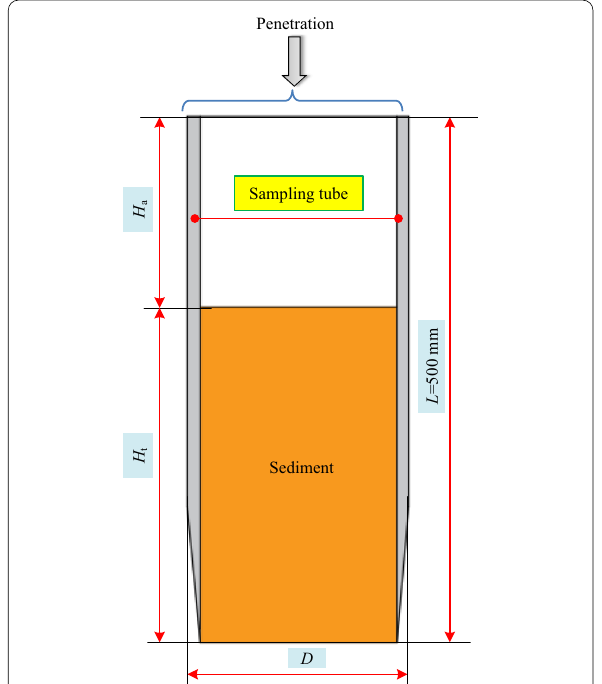
Figure 15 Measurement principle of experimental